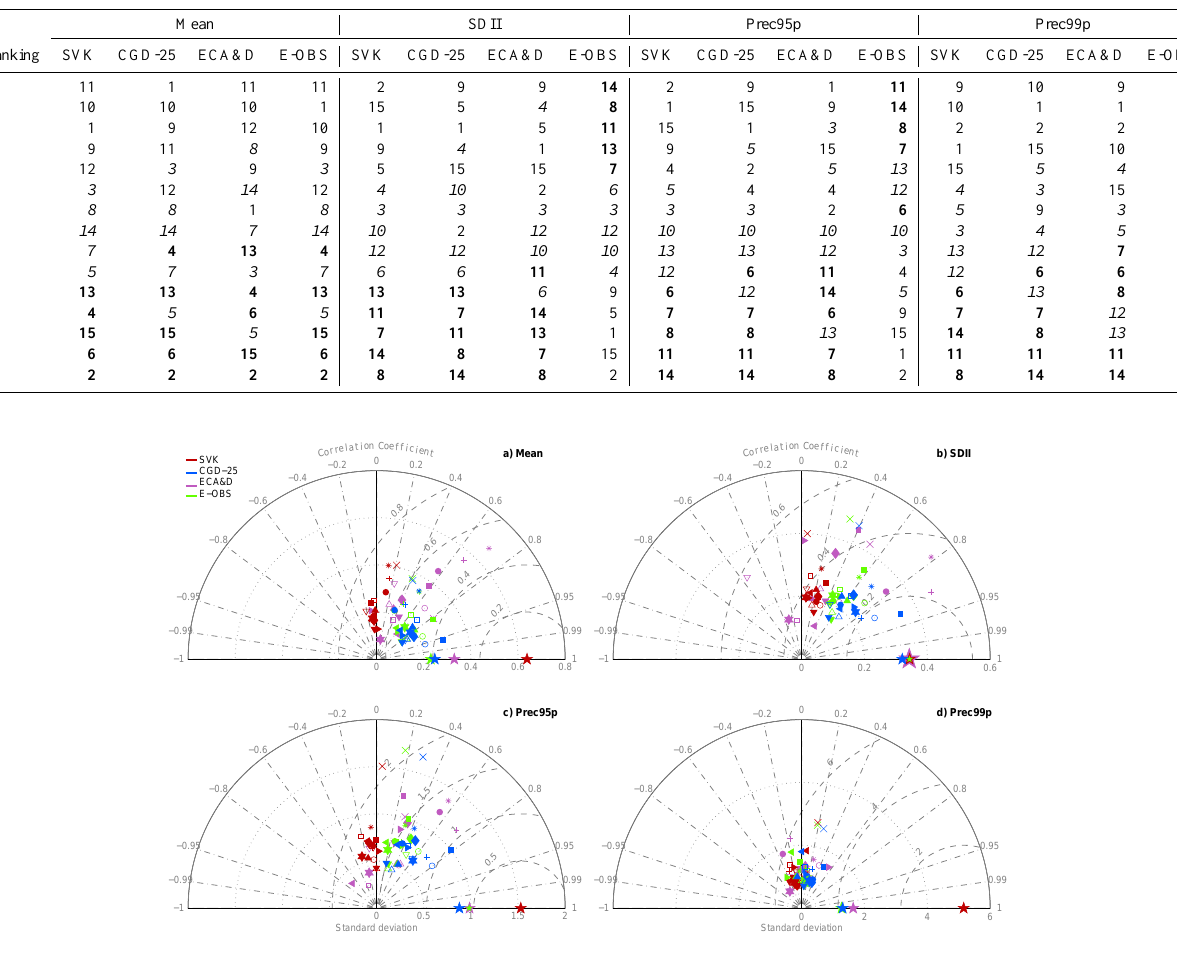
Fig. 6. Taylor diagrams showing the spatial correlation, centred RMSD, and the standard deviation for each of the RCMs when compared with each of the observational data sets (represented with stars in the line of correlation equal to 1). The different colours represent the observational data set used as a reference and the different markers show each of the RCMs in the ensemble. The values of the RMSD are shown using the SVK data set as a reference. For simplicity, the values of the RMSD for the other observational data sets are not